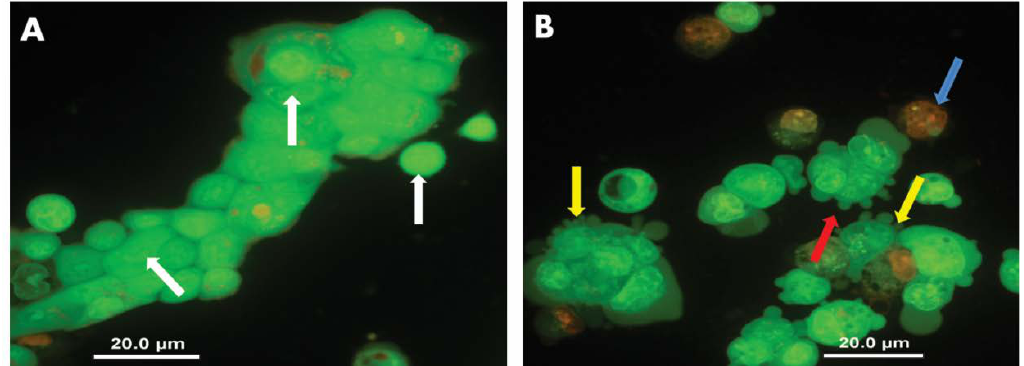
Figure 6. Effect of NCUR/MTX-2 on the morphology of Calu-3 cells stained with acridine orange/ethidium bromide by light fluorescence microscopy at 400× magnification. The negative control ( A , vehicle) presented viable cells with normal nucleus staining represented by the bright green chromatin (white arrows); NCUR/MTX-2 ( B ) showed early-stage apoptotic cells that were marked by crescent-shaped or granular yellow-green acridine orange nuclear staining (yellow arrows), late-stage apoptotic cells showing concentrated and asymmetrically localized orange nuclear ethidium bromide staining (blue arrow), and apoptotic membrane blebbing (red arrow). Images are representative of results obtained from three independent biological replicates (n = 6 slides per sample).